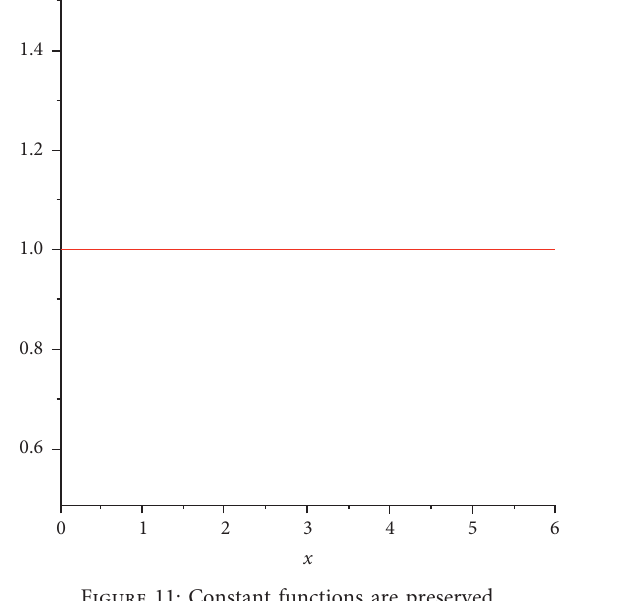
Figure 11: Constant functions are preserved.